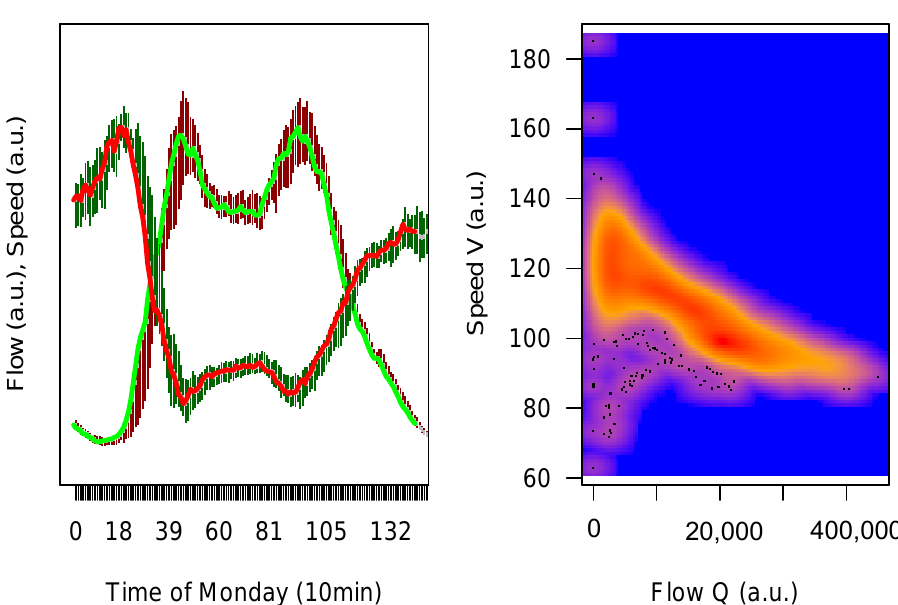
Figure 7. Zoom of the boxplot ( left ), aggregation is now in 10 min intervals. The speeds have been added to the flow. In the ( right ) panel, speed and flow are combined to a density plot, which is just the macroscopic fundamental diagram for the flow data (now in the data set’s native 5 min